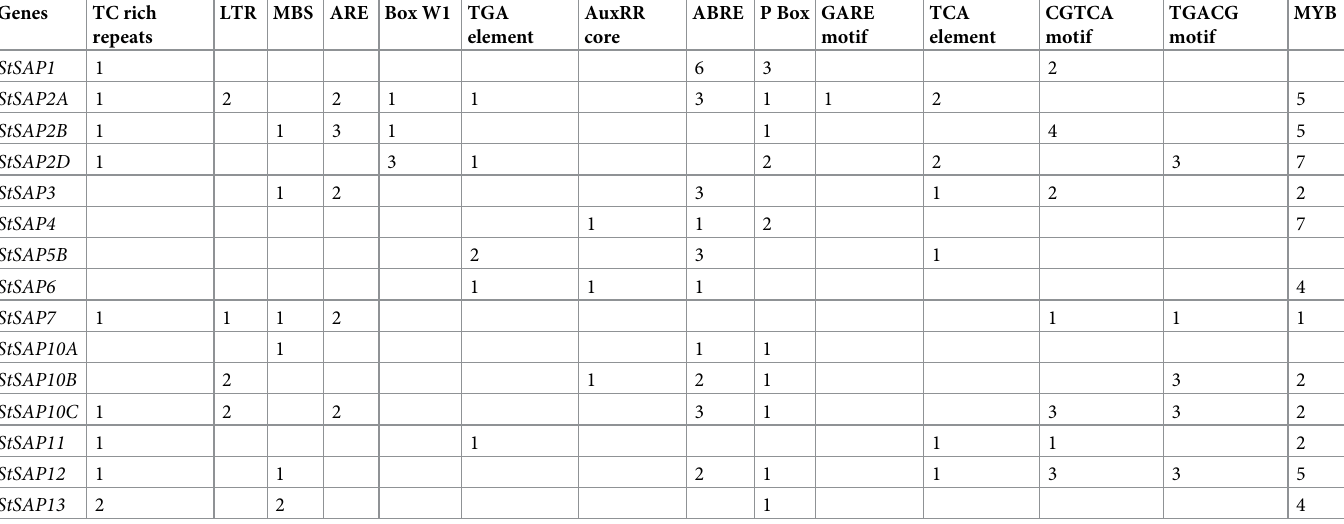
Table 5. Regulatory elements in the promoter regions of StSAP